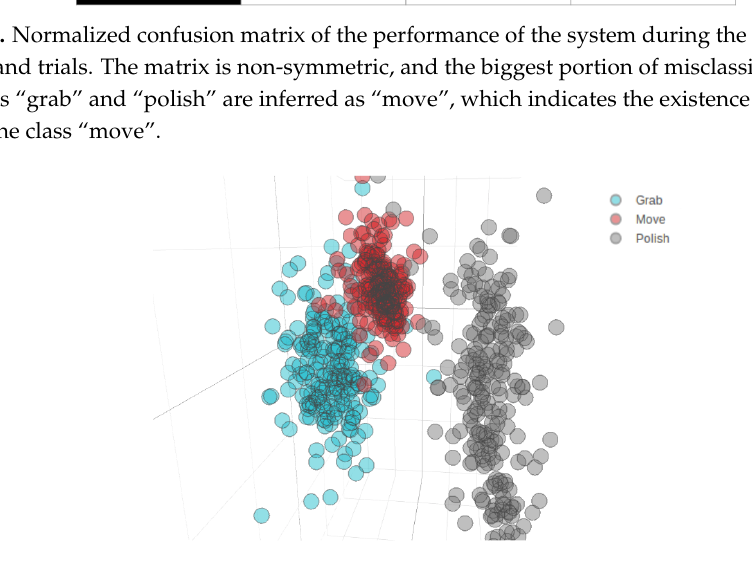
Figure 15. Single perspective of the data visualization using the three most discriminating latent variables from the original ten. The distribution of the data in this lower space shows that the samples of the class “move” are rather close to the other two classes, which could be the reason why the model seems to be a bit biased in favor of this